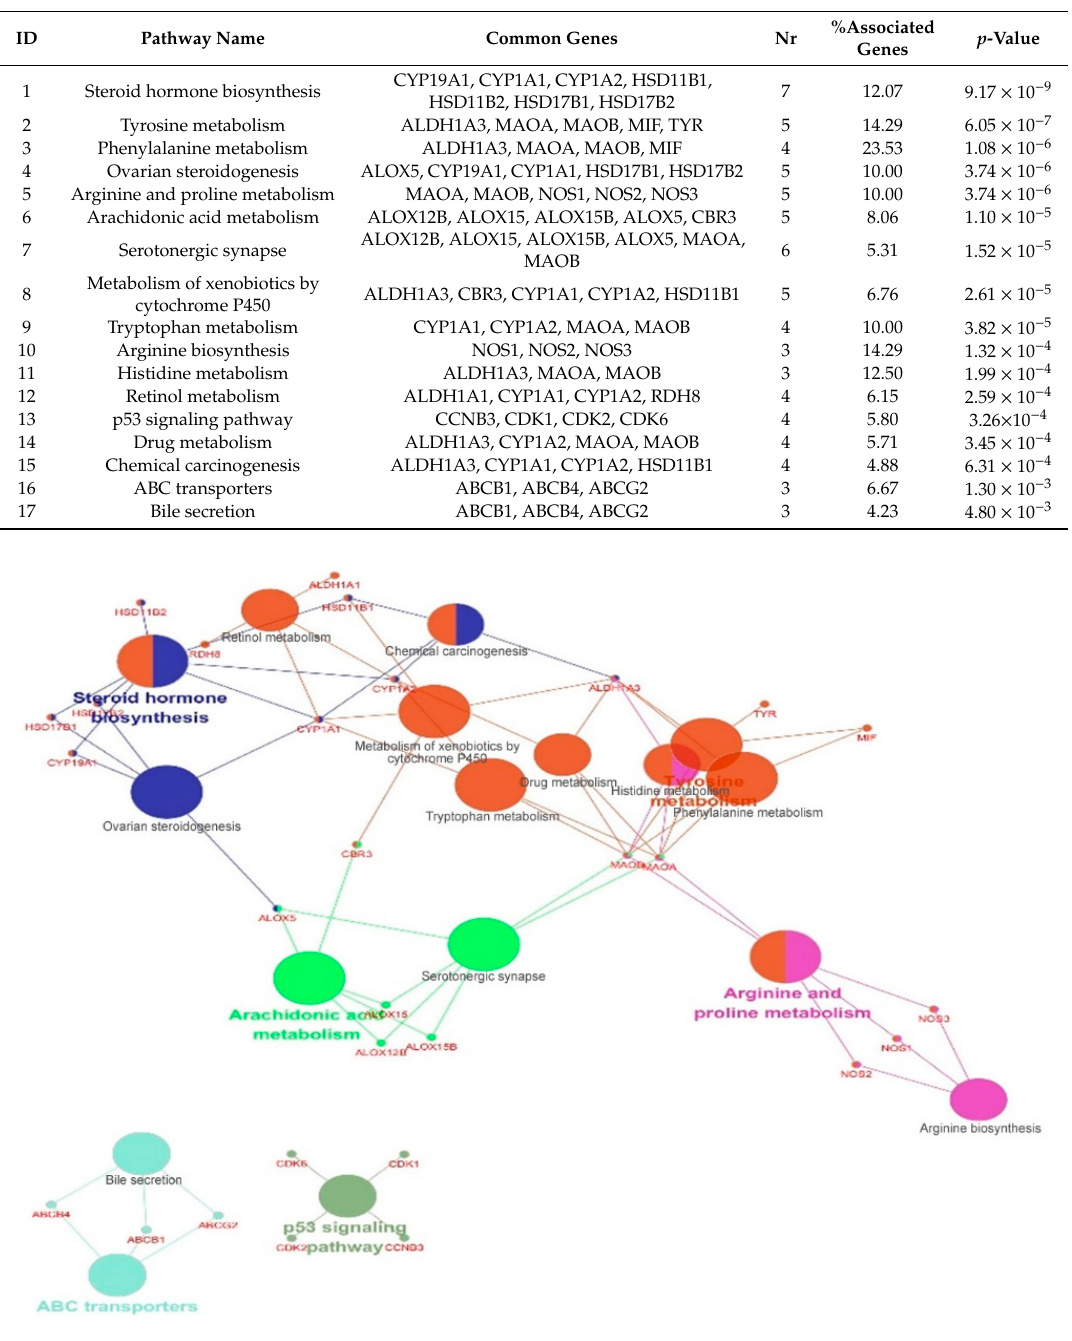
Figure 3. Pathway grouped network for the potential targets of licorice. Pathway grouped network for the potential targets of licorice with terms as nodes linked using ClueGO 2.3.5 analysis, where only the label of the most significant term per group is shown. The node size represents the term enrichment significance and the color of the node reflects the enrichment